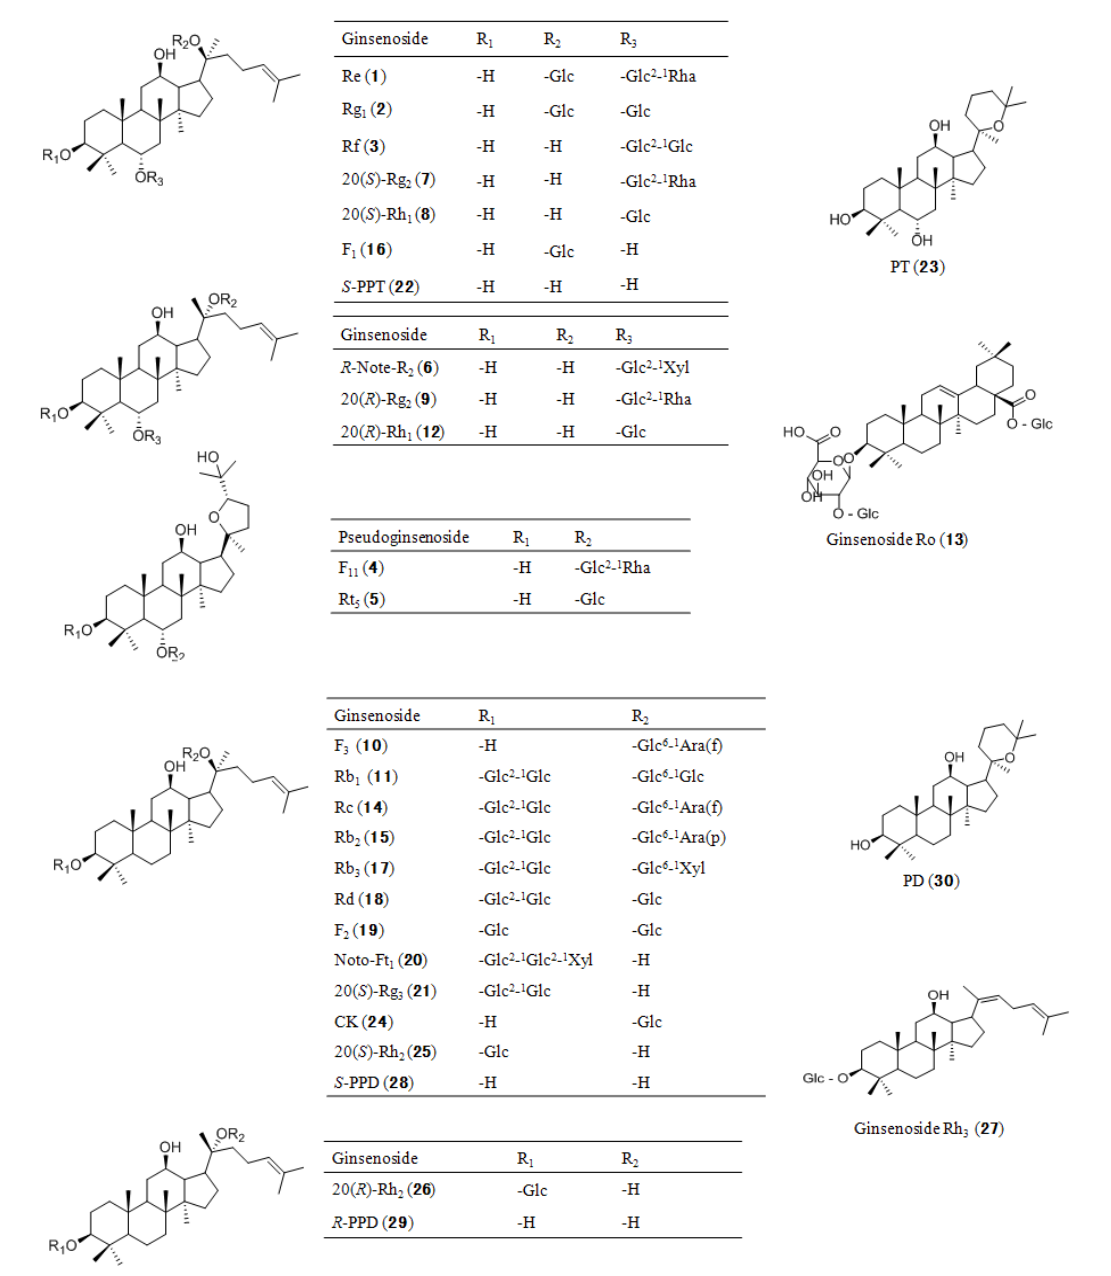
Figure 1. Chemical structures of 30 ginsenosides and aglycones. Glc, β - D -glucopyranosyl; Ara(p), α - L -arabinopyranosyl; Ara(f), α - L -arabinofuranosyl; Rha, α - L -rhamnopyranosyl; Xyl, β - D